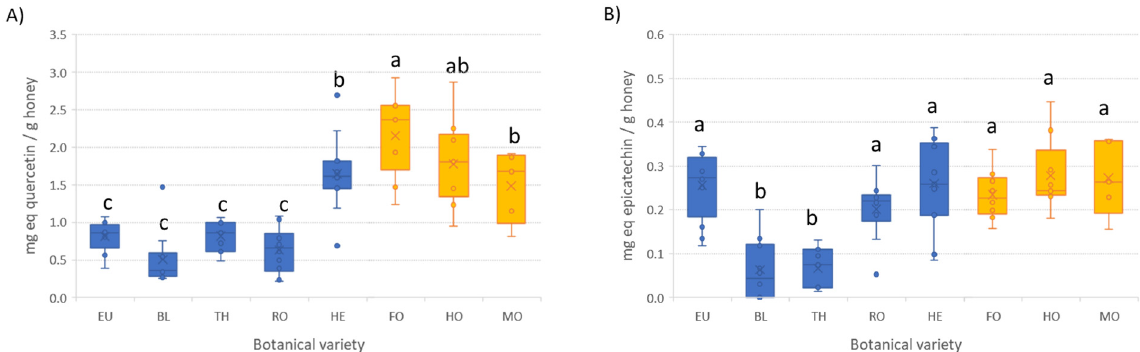
Figure 2. Boxplots with the total flavonoid content in honey samples according to the botanical origin. ( A ) method I (absence of NaNO 2 ) and ( B ) method II (presence of NaNO 2 ). For botanical origin code refer to Table 1. Blue boxes correspond to blossom honeys, while orange ones correspond to honeydew honeys. The same letter indicates no significant differences ( α = 0.05).